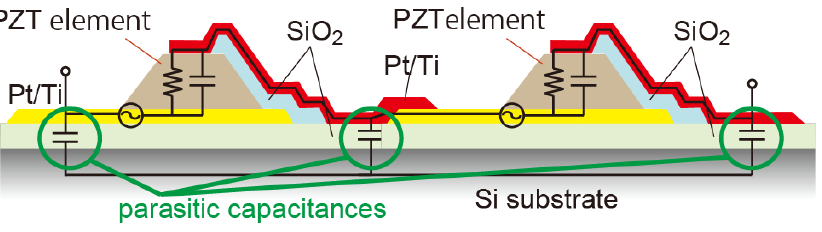
Figure 2. Insulation layers below bottom electrodes form parasitic